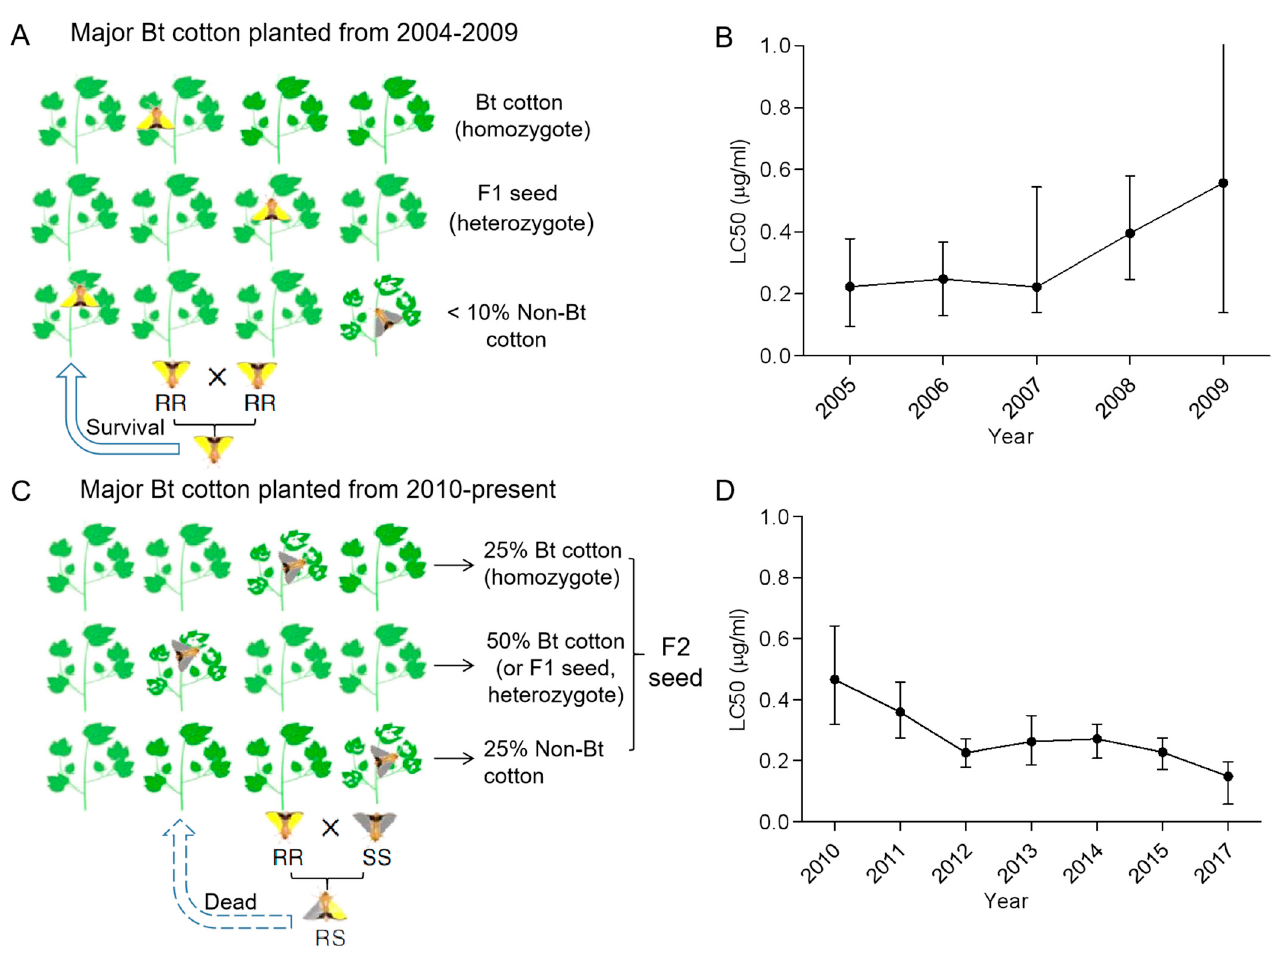
Figure 2. Major Bt cotton planted ( A , B ) and field monitoring of Pectinophora gossypiella Cry1Ac resistance ( C , D ) in China. LC50 represents the median lethal concentration of the Cry1Ac protein to the collected larvae, and error bars stand for the 95% fiducial limits. The percent of cotton planted and bioassay data of LC50 from 2004-present are from Wan et al. [23].